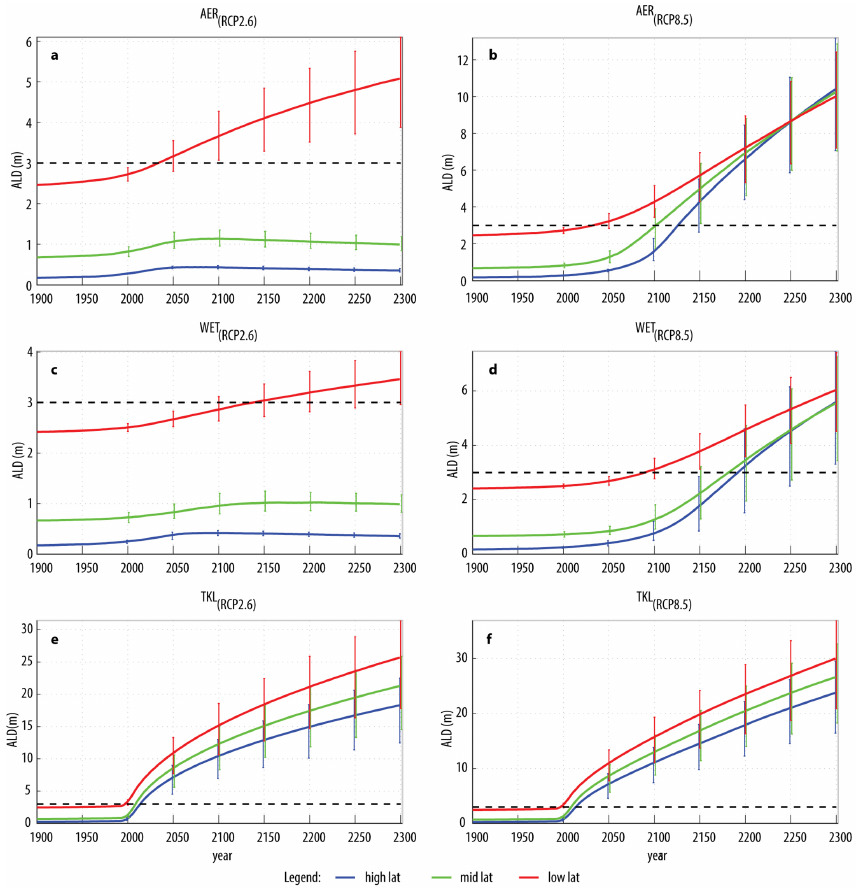
Figure 2. Simulated changes in active layer depths (ALDs) for mineral soils under moderate (RCP2.6) and extensive (RCP8.5) warming (left and right panels). Shown is the deepening of the active layer from the year 1900 until 2300 for a north–south gradient of different initial permafrost temperatures (blue: MAGTt0 =− 10 ◦ C, green: MAGTt0 =− 5 ◦ C, red: MAGTt0 =− 0.5 ◦ C) and for different hydrologic conditions ( a , b : aerobic, c , d : wetland, e , f : thermokarst lake). We assume that newly formed lakes reach the critical depth which prevents winter refreeze by the year 2000. Vertical bars illustrate the model spread inferred from an ensemble of 500 runs (68% range). The horizontal dashed lines denote the near-surface permafrost boundary (3m). Note the different y -axis scales.